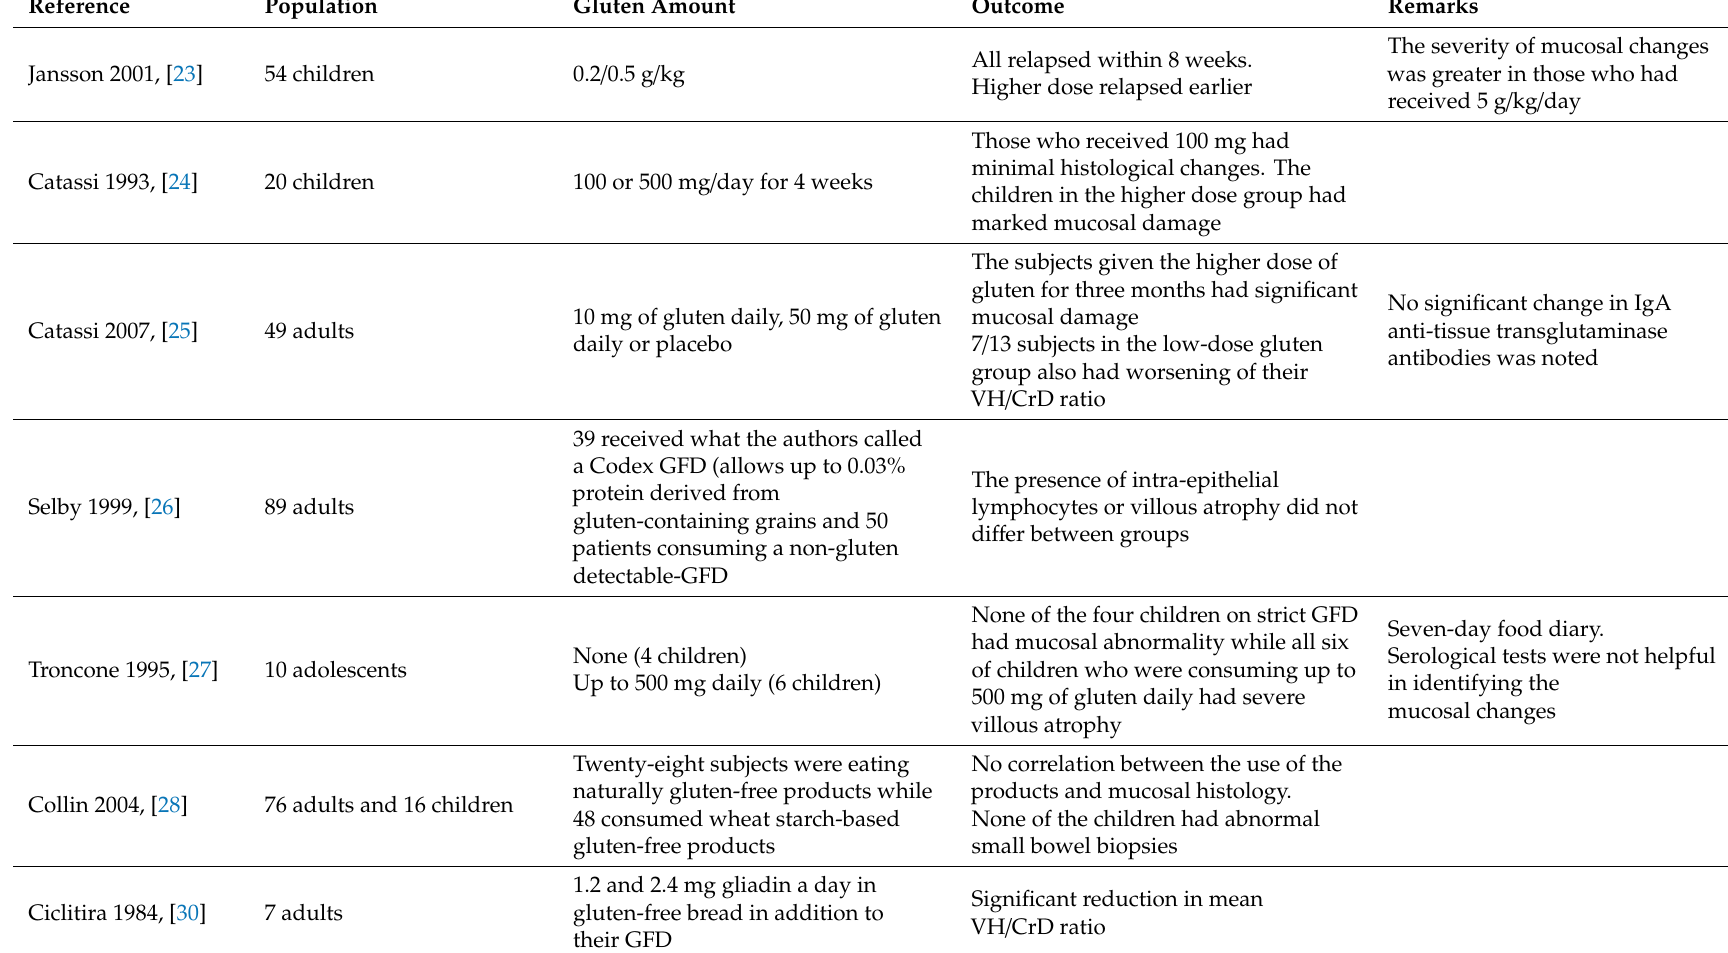
Table 1. Relationships between gluten exposure and